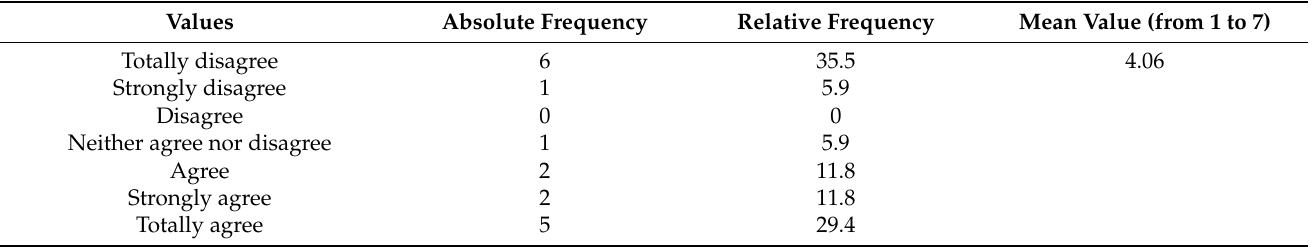
Table 8. Analysis of the results for item 8: “I have delayed motherhood for my professional career”.